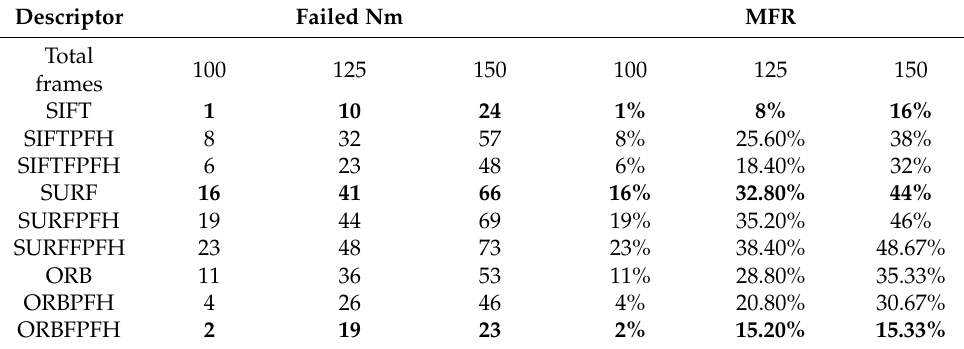
Table 4. Failure rate of feature matching in the KITTI fire